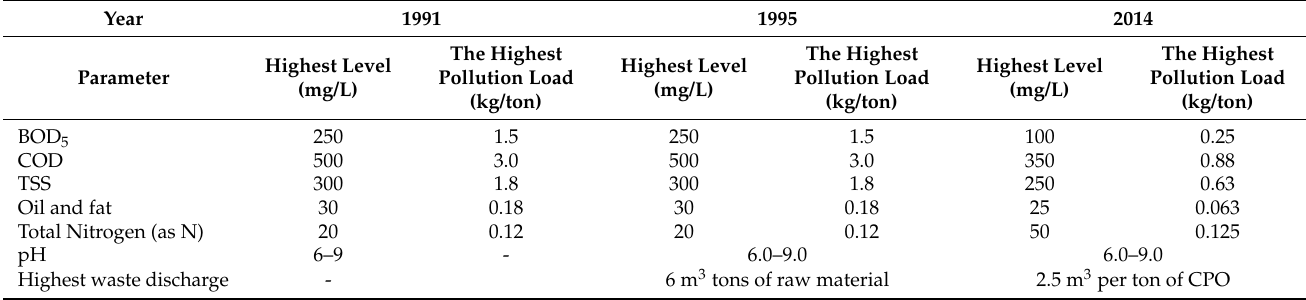
Table 2. Effluent standards for the POME wastewater in Indonesia